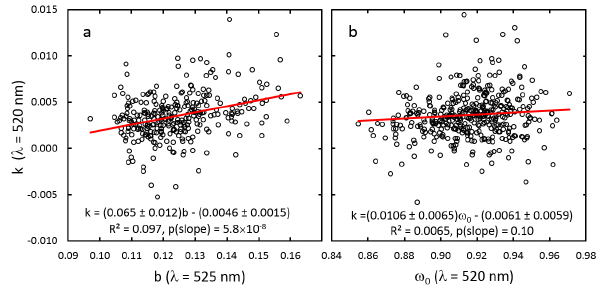
Figure 11. Compensation parameters at the aethalometer green wavelength ( λ = 520nm) as a function of (a) the backscatter frac- tion b and (b) the single-scattering albedo ω 0 when b and ω 0 were in a narrow range: (a) contains data from those filter changes during which the filter-spot-averaged ω 0 (λ = 520nm) = 0.930 ± 0.005. (b) contains data from those filter changes during which the filter- spot-averaged b(λ = 525nm) = 0.130 ± 0.005. The red lines and the equations represent linear regressions fitted to the